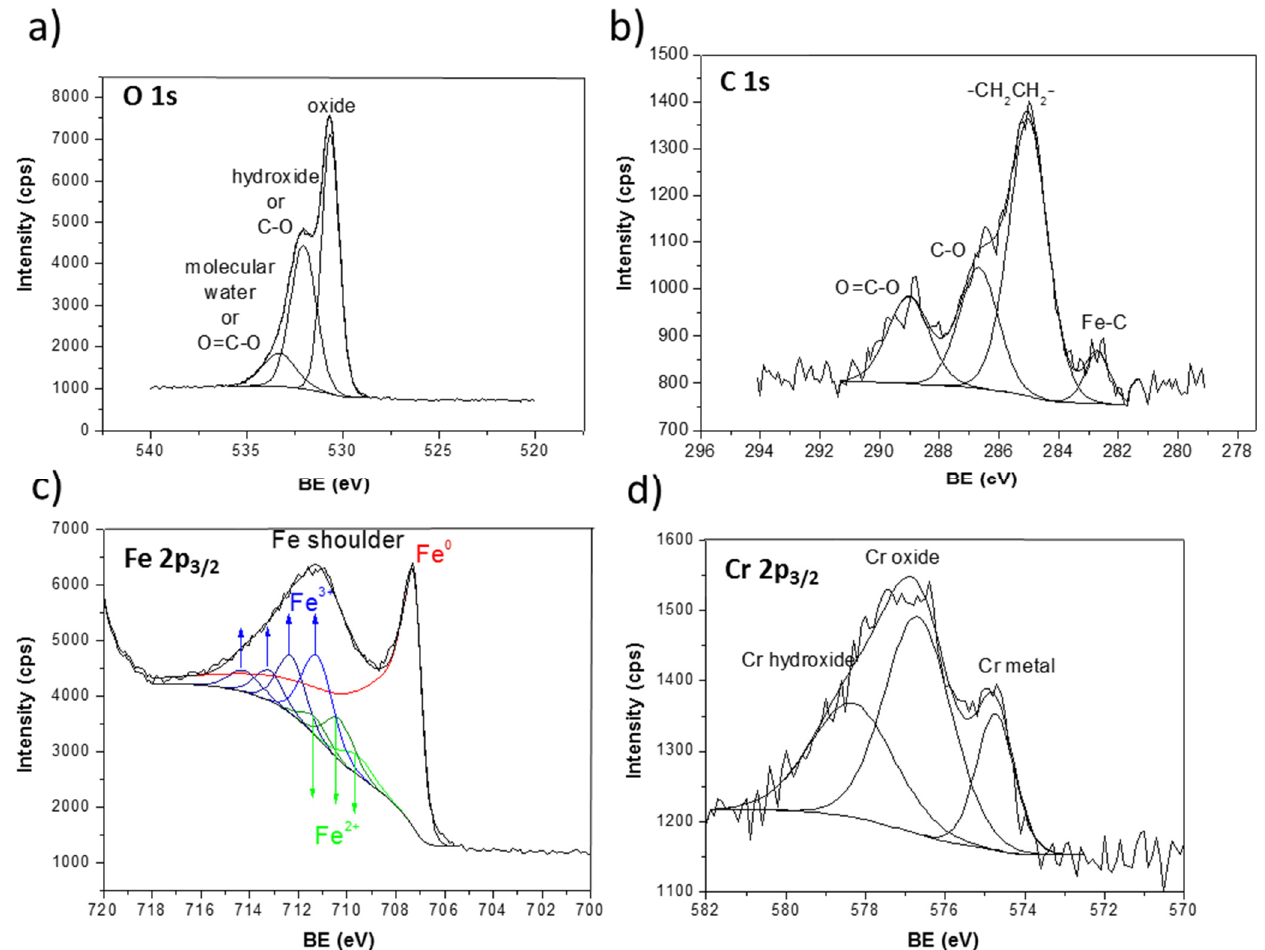
Figure 8. XP spectra for Fe-5% Cr pristine sample ( a ) O 1s, ( b ) C 1s, ( c ) Fe 2p, ( d ) Cr